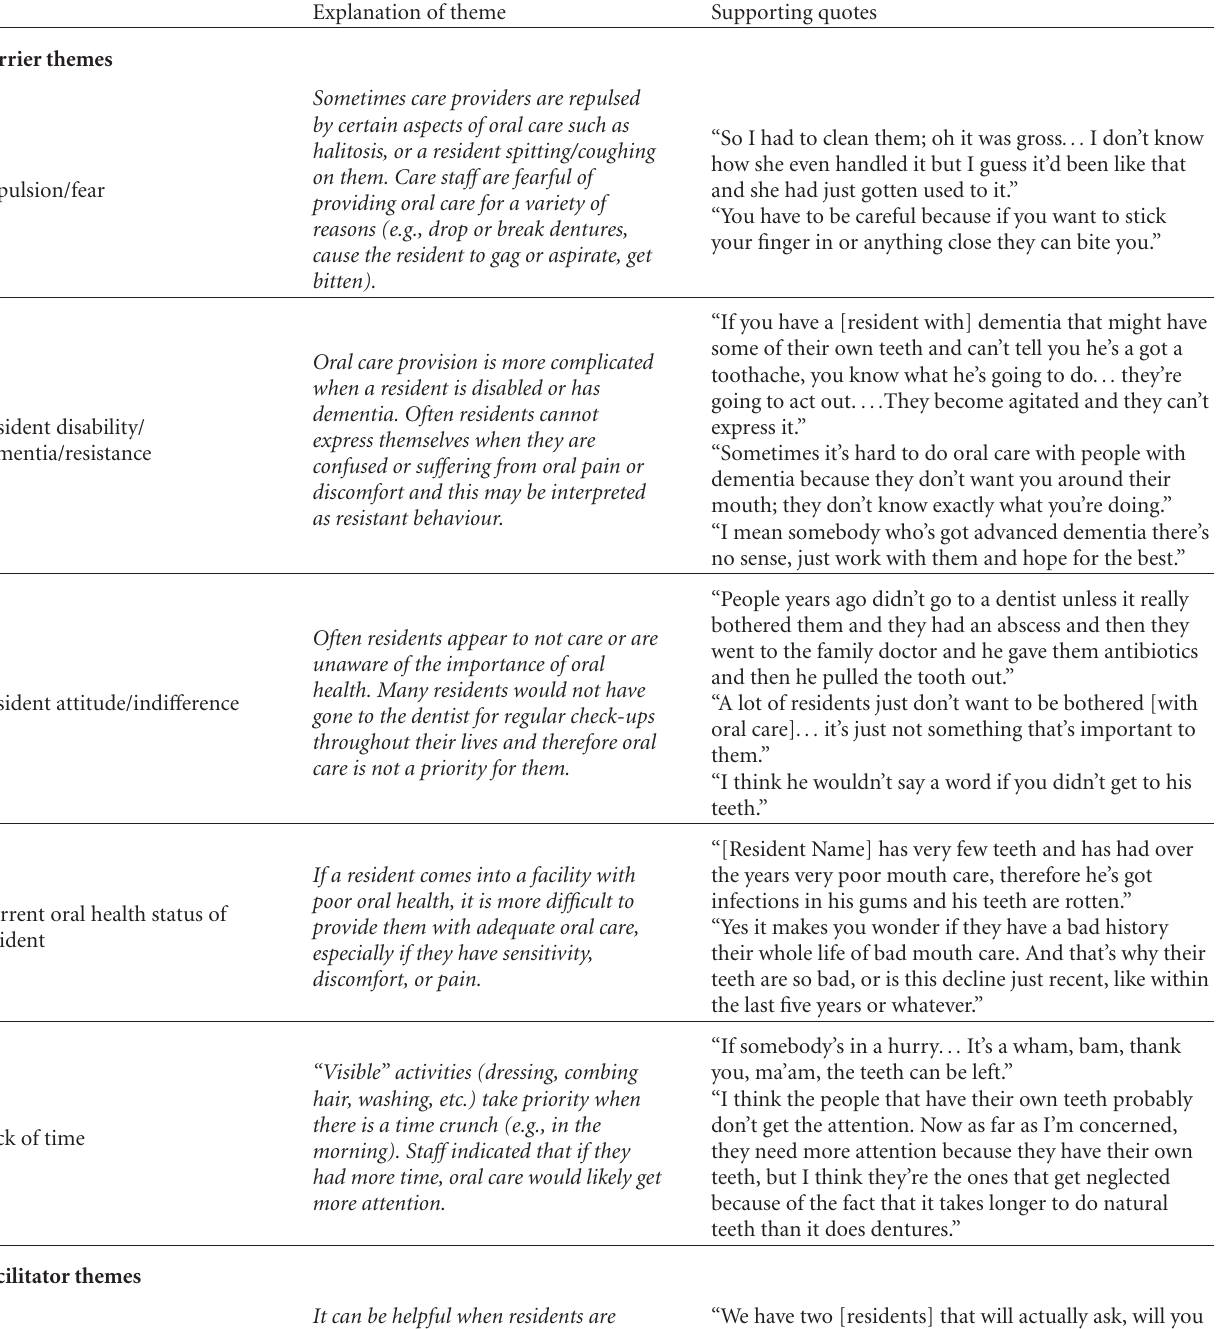
Table 2: Personal care providers narrative findings—barriers, facilitators and education. Explanation of theme Supporting